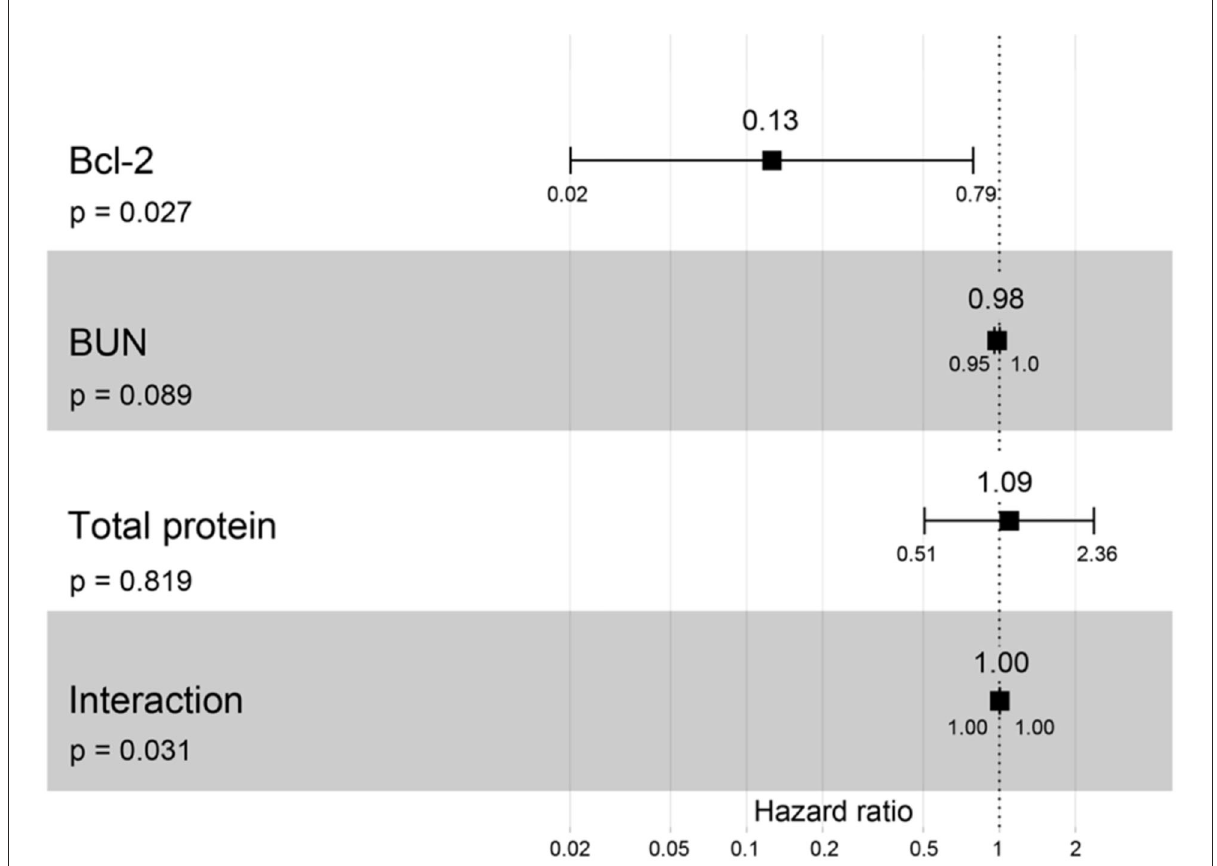
FIGURE11 Forest plot output for the interaction of Bcl-2 with two different covariates (BUN and total protein) with CKD progression based on hazard ratios (HRs) via Cox regression analysis. Squares represent hazard ratios. Bars represent 95% confidence